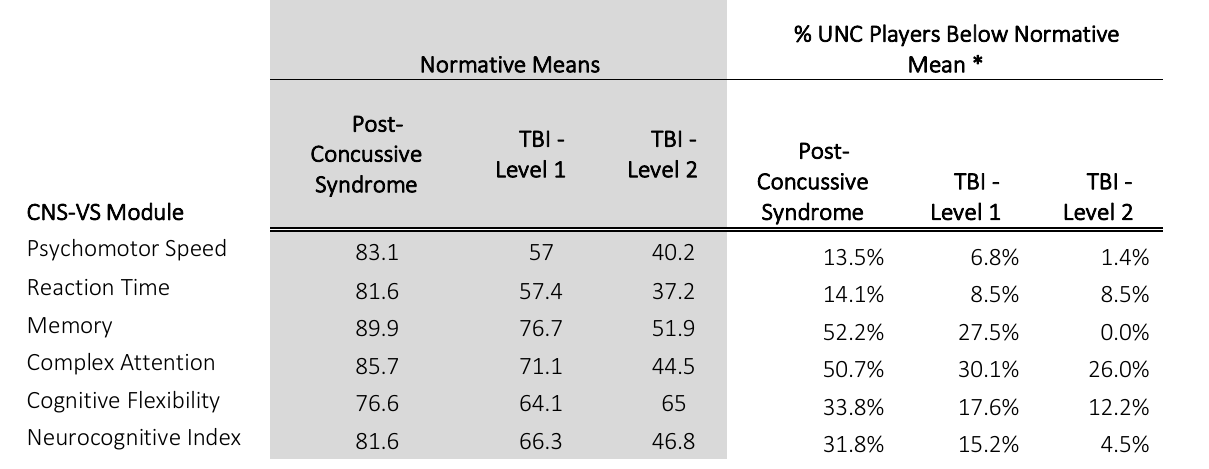
Table 3: Incoming UNC Football Players Scoring Below TBI Patient Means on CNS-VS Baseline Testing